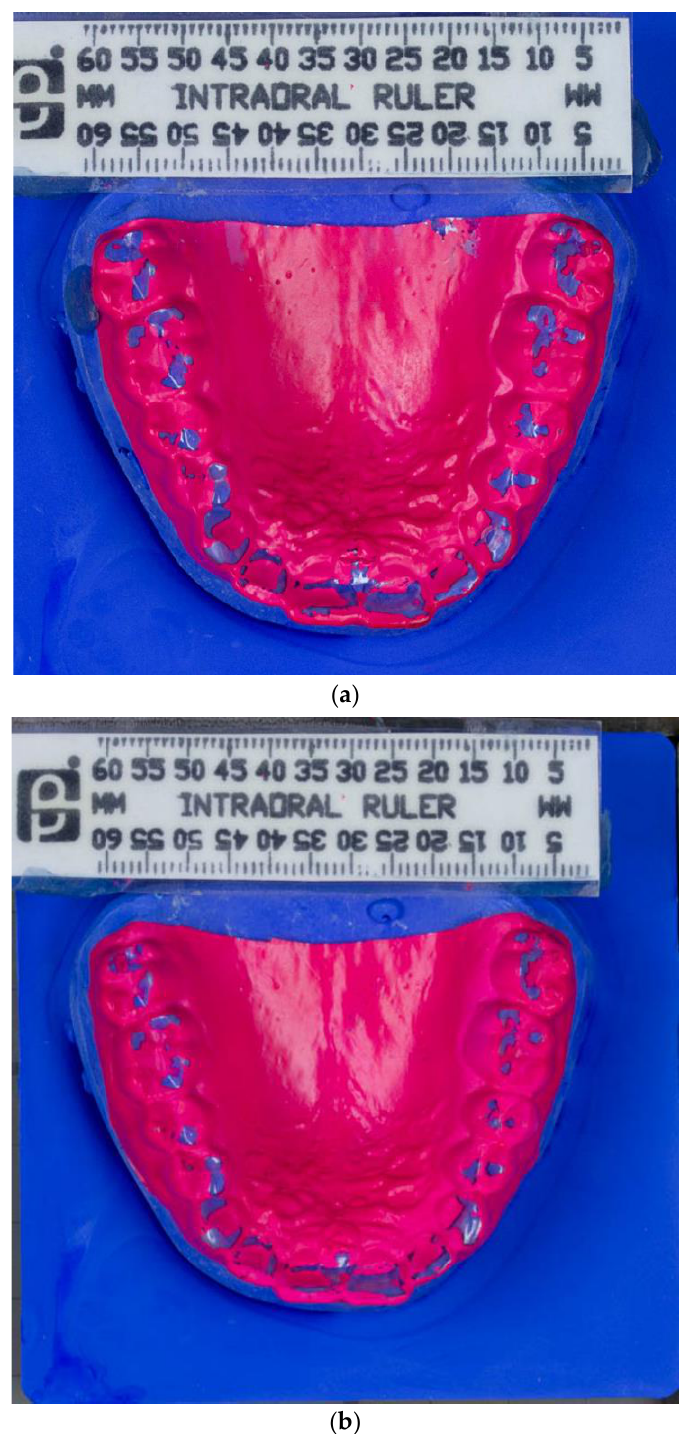
Figure 1. ( a ) Photograph of BruxChecker ® foil after wear “stress” phase . ( b ) Photograph of BruxChecker ® foil after wear “consecutive” phase.